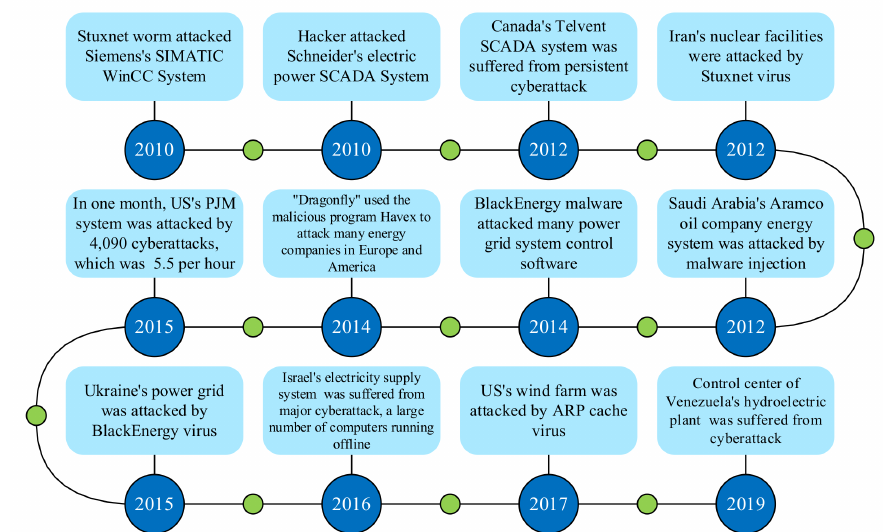
Figure 1. Actual cases of cyber-attacks against power